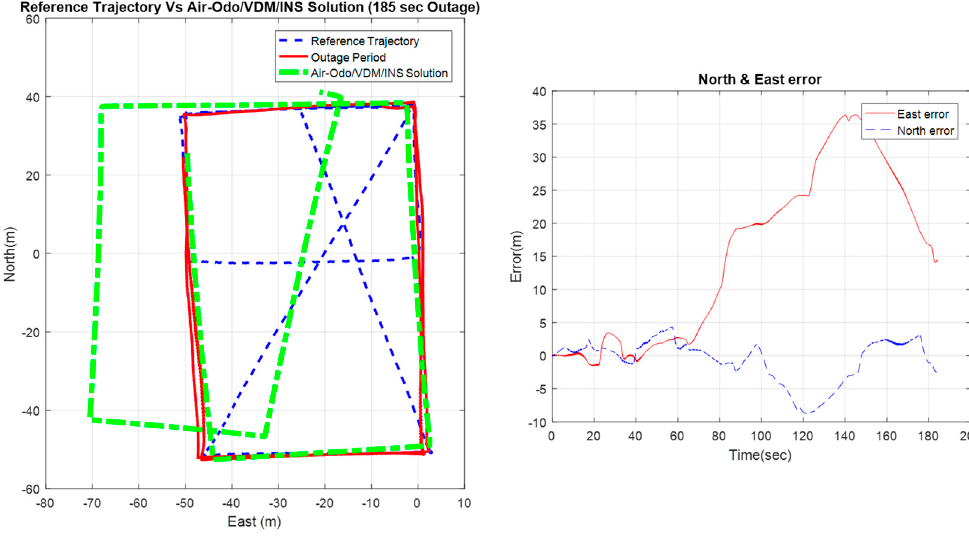
Figure 17. Air-Odo/vehicle dynamic model/INS integration performance during 185 of complete GNSS signal outage.